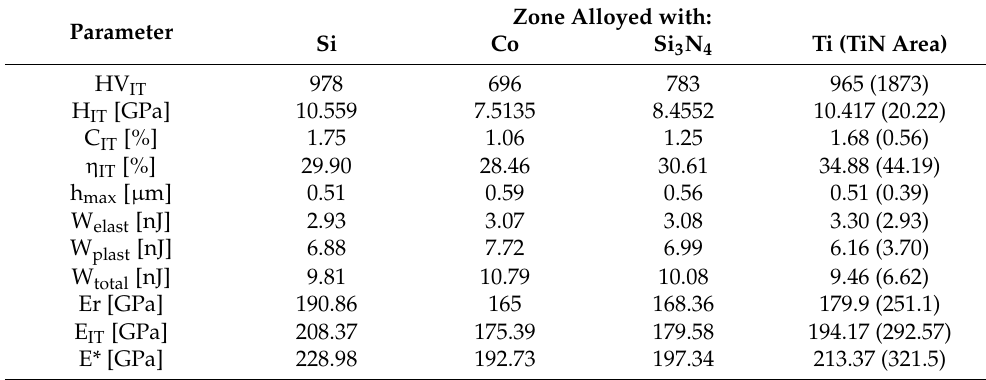
Table 3. Nanoindentaion test